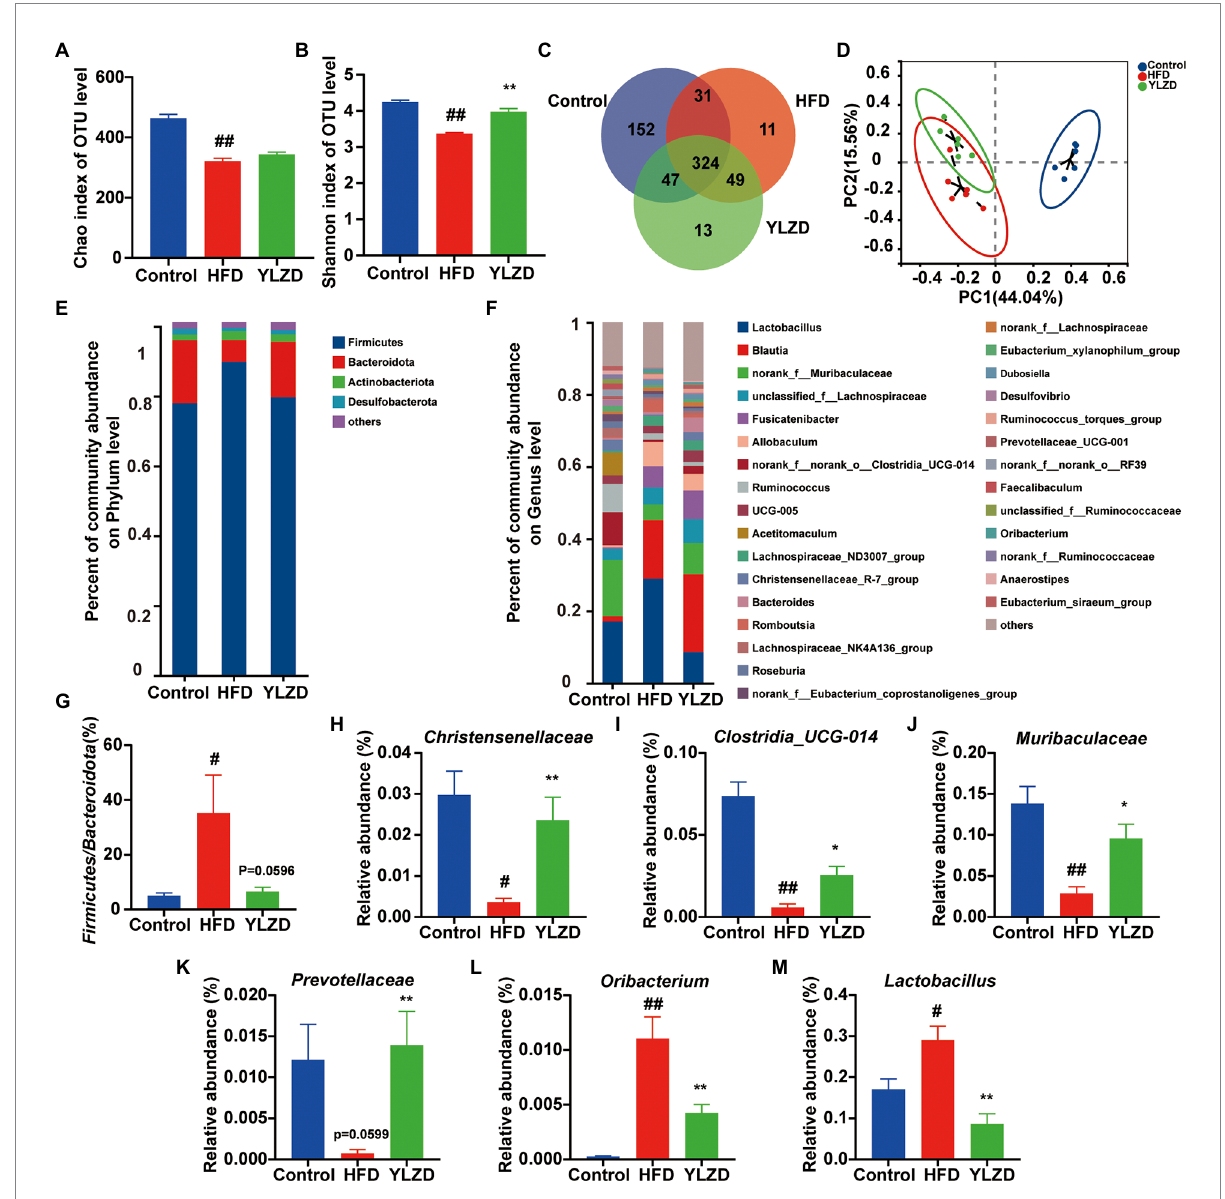
FIGURE 6 YLZD remodeled the composition of gut microbiota. (A,B) The bacterial diversity in intestinal estimated by alpha-diversity of chao and Shannon indexes. (C) Venn diagram of the overlap of the OTUs in the gut microbiota in different treatments. (D) The β -diversity analysis of Principal Coordinate Analysis (PCoA). (E) Bar plot of the gut microbiota at the phylum level. (F) Bar plot of the gut microbiota at the genus level. (G) The ratio of Firmicutes to Bacteroidetes . (H–M) Changes in the abundance of Christensenellaceae , Clostridia_UCG-014 , Muribaculaceae , Prevotellaceae , Oribacterium and Lactobacillus , respectively. Values are represented as mean ± SEM ( n = 6 rats/group). ## p < 0.01, # p < 0.05 versus the Control group; ** p < 0.01, * p < 0.05 versus the HFD